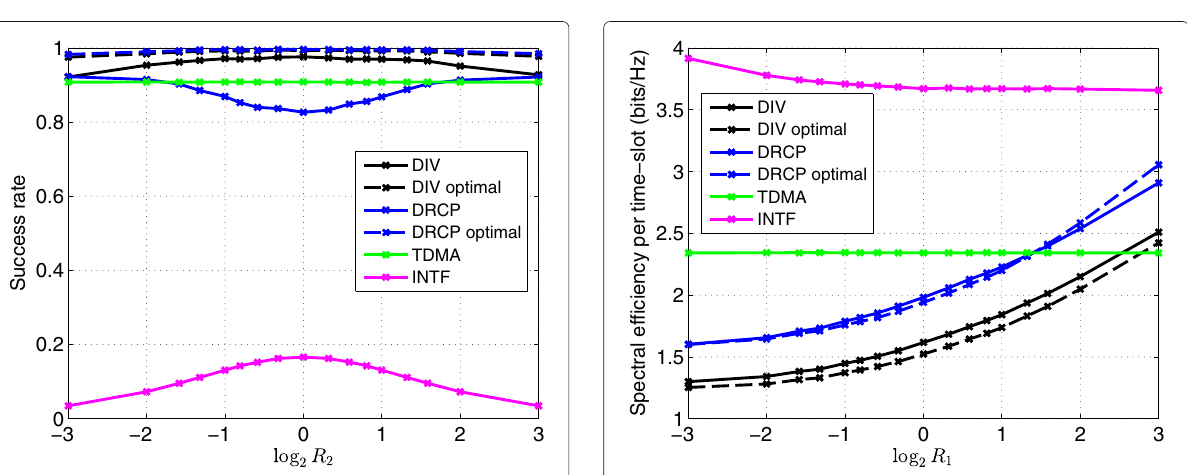
For the circuit power-dominated regime, our simula- for the transmit power-dominated regime that DIV and tions show a similar trend where the energy efficiency of DRCP achieve the highest energy efficiency and success R 1 as seen in Fig. 6. DIV and DRCP increase with log rate when the minimum spectral efficiencies are small. 2